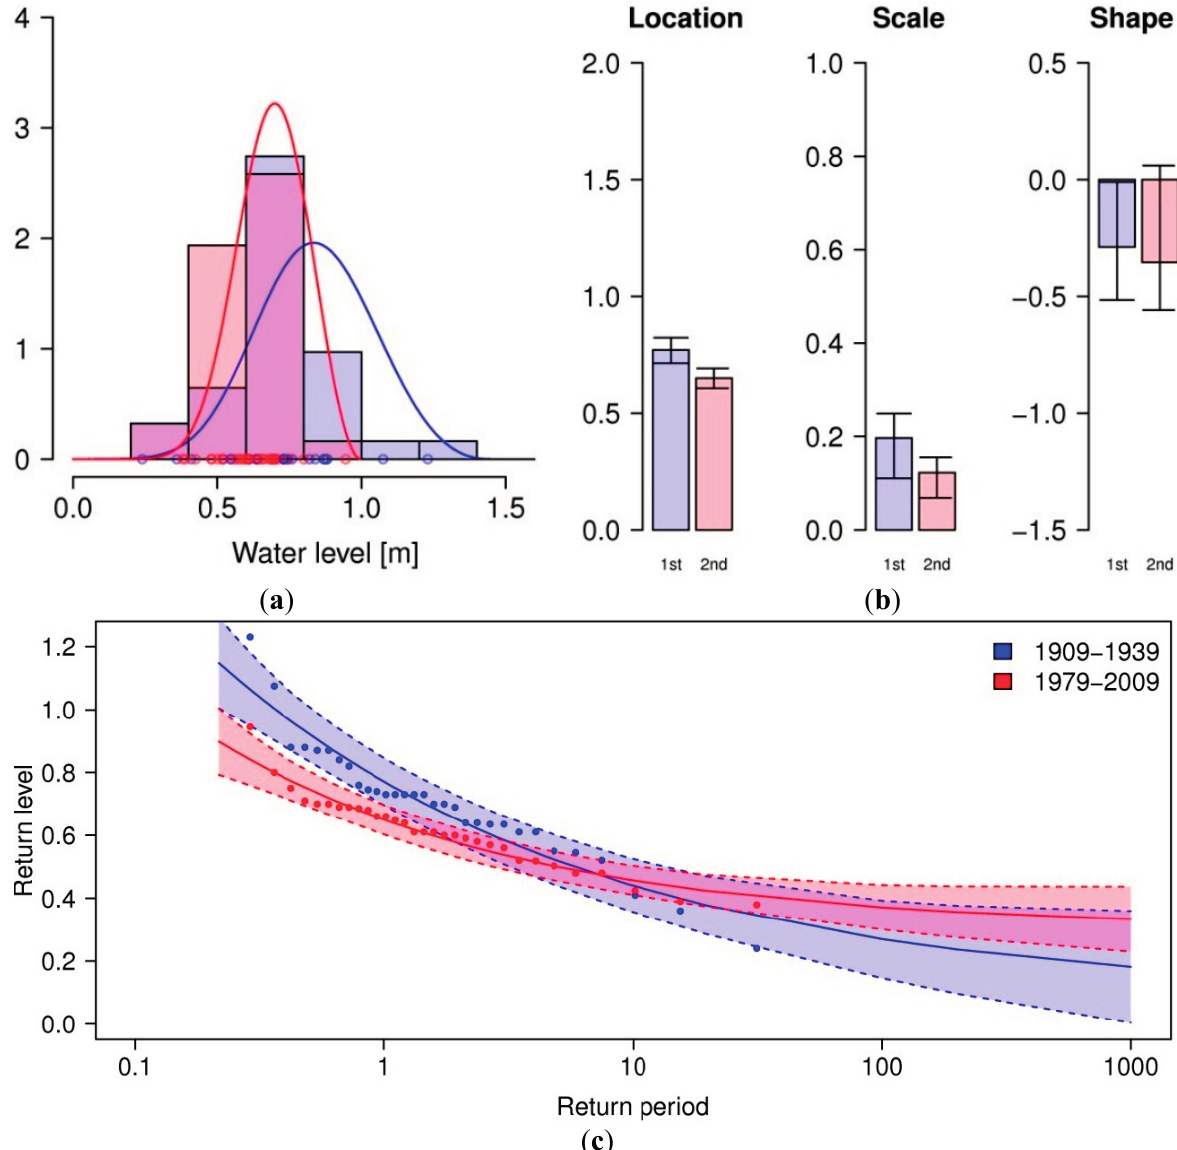
Figure 3. ( a ) shows the GEV distributions fitted to annual minimum water levels for 1909– 1939 (blue) and 1979–2009 (red), estimated parameters location µ, scale σ and shape ξ are plotted in ( b ). Error bars depict 95% confidence intervals obtained from non-parametric bootstrapping ( R = 500). Return level plots with 95% confidence intervals are shown in ( c